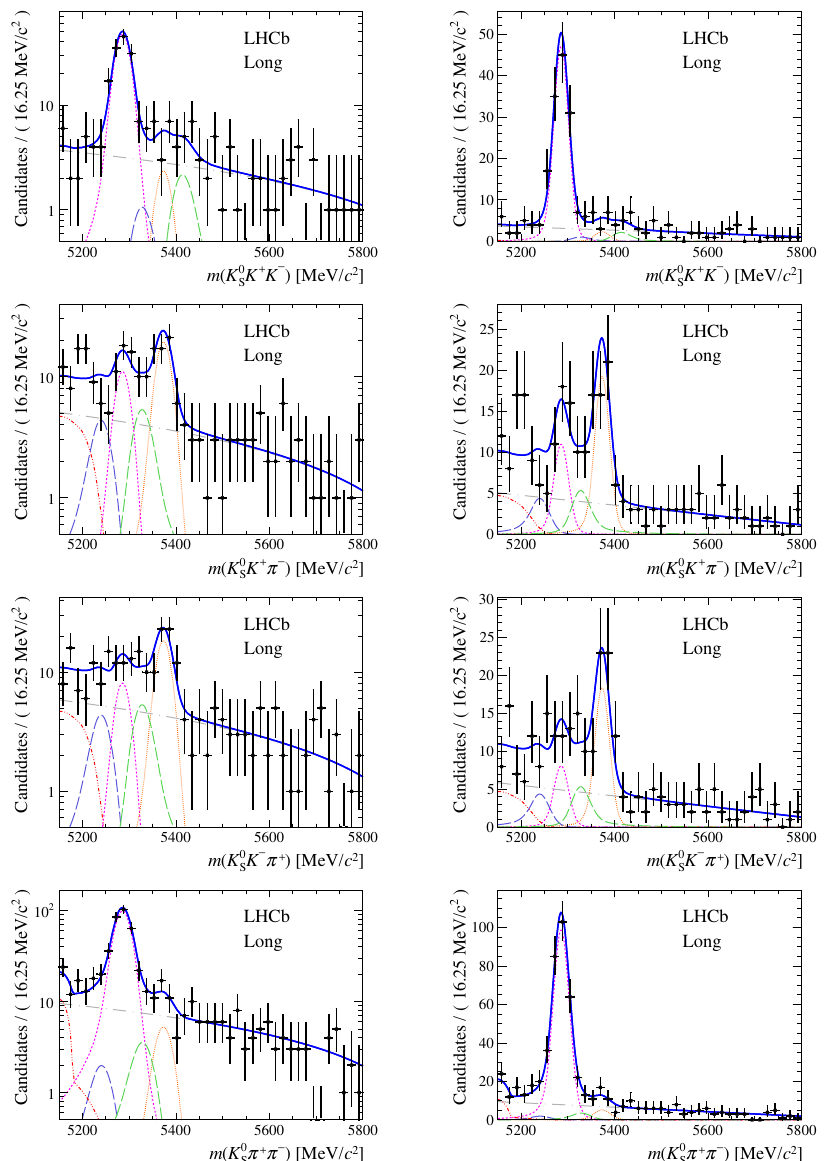
Figure 7 . Results of the simultaneous (cid:12)t to data (long, 2012a) with the BDT optimisation corre- sponding to the favoured decay modes. The modes K 0 are shown from top to bottom. The left-hand side plots show the results with a logarithmic scale and the right-hand side with a linear scale. Legend is similar to that of plots shown in (cid:12)gure 1.